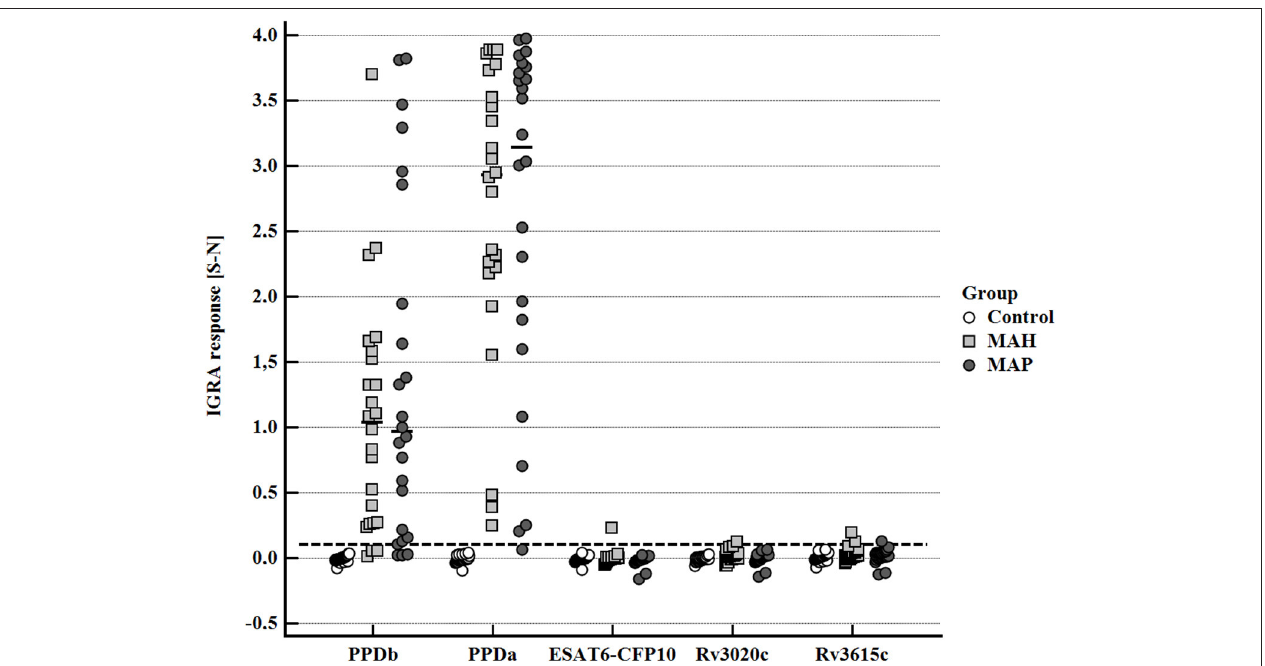
FIGURE 4 | Whole blood IFN- γ response of MAH or MAP inoculated goats vs. control animals induced by bovine PPD (PPDb, 300U), avian PPD (PPDa, 250U), and recombinant M. bovis antigens ESAT6-CFP10, RV3020c, and RV3615c (5 µ g/mL each). Data of three time points (19–22, 27–30, and 45–48 wpi) are summarized. Each dot represents one animal; bars represent medians. The dashed line indicates the lower limit of a positive IFN- γ response [S- N] to stimulation with either PPDb or